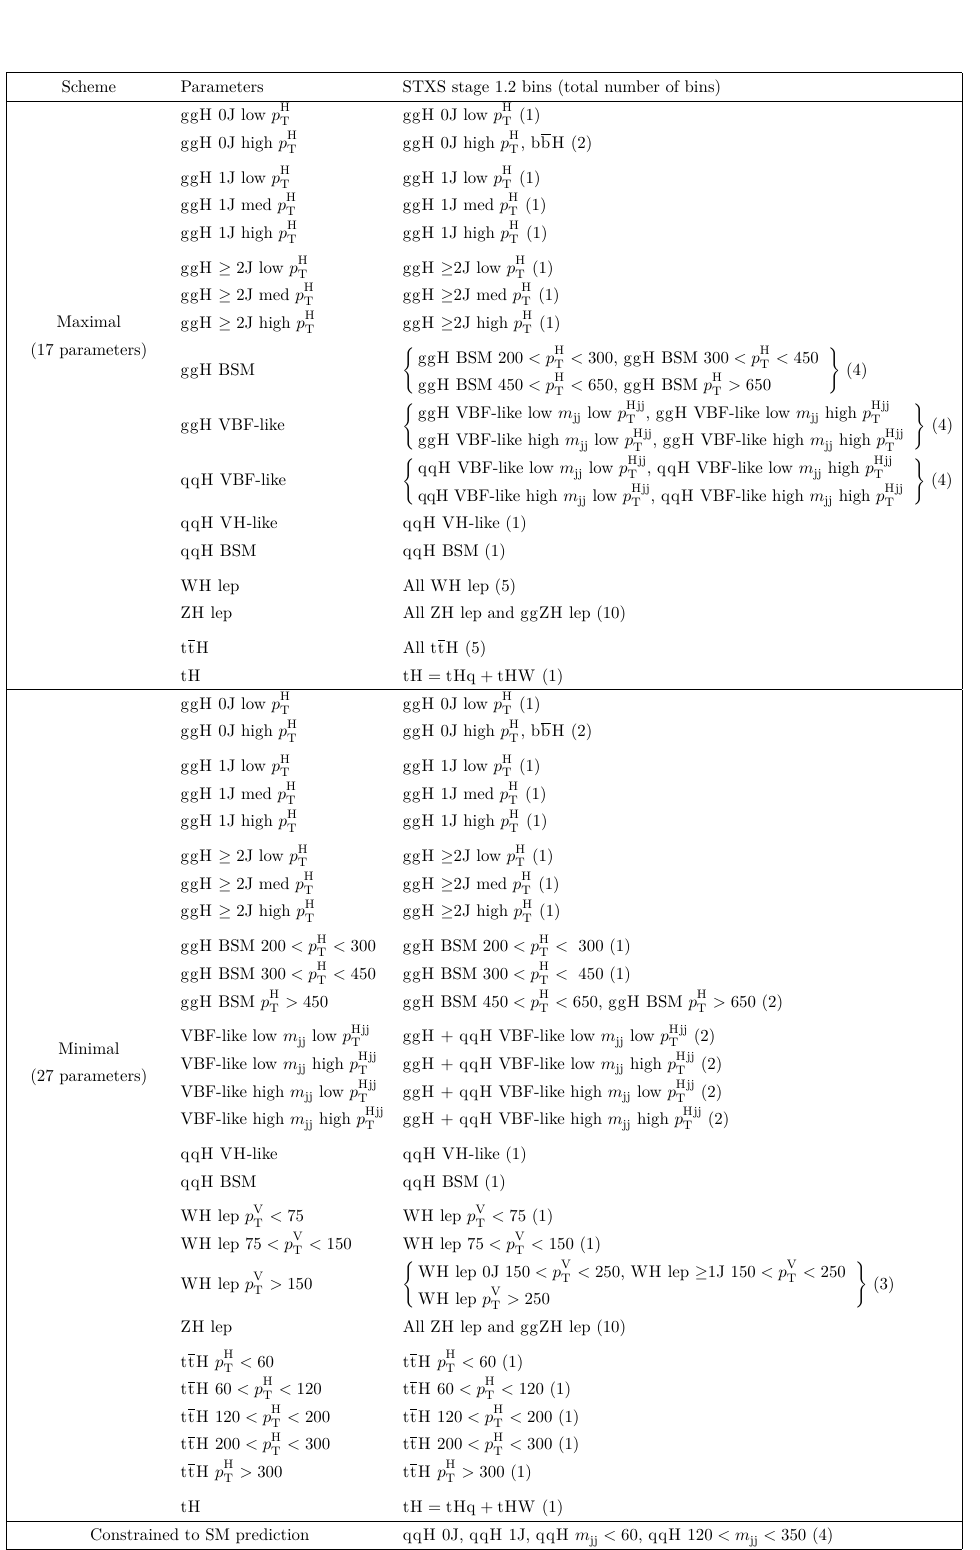
Table 11 . A summary of the maximal and minimal parameter merging scenarios. The STXS bins that contribute to each parameter are listed. Furthermore, the bins that are constrained to their respective SM predictions in the fits are listed in the final